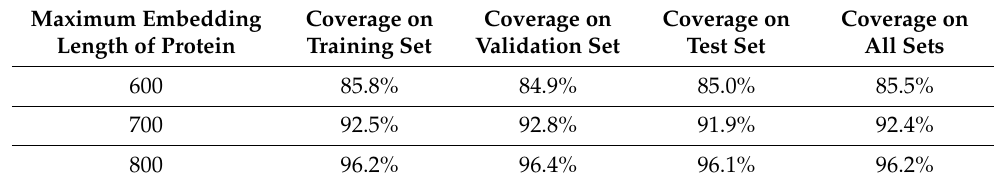
Table A1. Protein maximum length coverage.